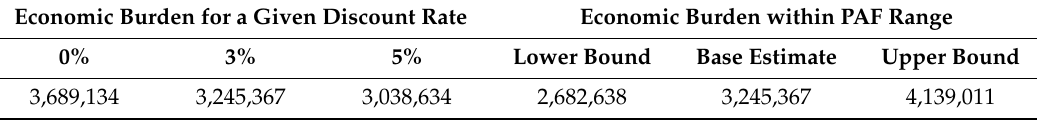
Table A2. Sensitivity analysis of infection-related cancer costs regarding discount rates and PAF range (Unit: 1000